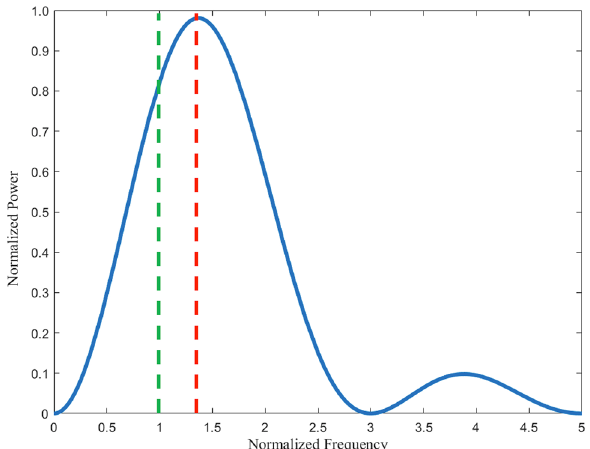
Figure 3. Calculated frequency spectrum for the modified rotating dipole lasting ½ of a full orbital period. The peak emission occurs at a normalized frequency at ~ 1.36. Another peak occurs at ~